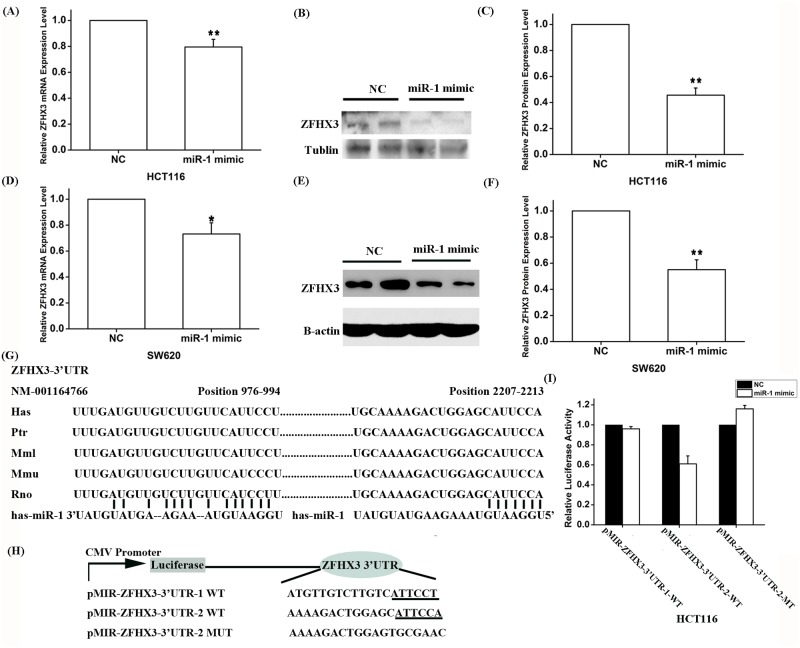
Expression of ZFHX3 is negatively regulated by miR-1.HCT116 (A-C) and SW620 (D-F) cells were transfected with miR-1 mimics and negative control mimics (NC) and used for isolation of RNA samples for real-time RT-PCR analysis or for isolation of protein extracts for Western blot analysis for the expression levels of ZFHX3 mRNA and protein. A. Real-time RT-PCR analysis revealed that the miR-1 mimics reduced the expression of ZFHX3 by 20% in HCT116 cells (P = 0.004). B, C. Western blot analysis revealed that the miR-1 mimics reduced the expression of the ZFHX3 protein by 54% in HCT116 cells (P = 6.84×10-5). D. Real-time RT-PCR analysis revealed that the miR-1 mimics reduced the expression of ZFHX3 by 27% in SW620 cells (P = 0.01). E, F. Western blot analysis revealed that the miR-1 mimics reduced the expression of the ZFHX3 protein by 45% in SW620 cells (P = 4.887×10-4). G. Identification of two putative miR-1 binding sites at the 3’-UTR of ZFHX3 by bioinformatic analysis and alignment of miR-1 binding sequences across species. H. A schematic diagram shows luciferase reporters containing the potential miR-1 binding site or the related mutated site. I. MiR-1 targets the second miR-1 binding site to regulate expression of ZFHX3. Luciferase assays revealed that compared to negative control mimics, miR-1 mimics significantly reduced luciferase activities from pMIR-ZFHX3–3’-UTR-2, but not from pMIR-ZFHX3-3’-UTR-1. *P<0.05; **P<0.01.